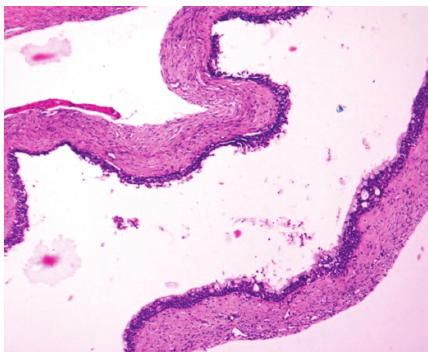
Figure 4: Cystic lining with connective tissue stroma (H&E 20x).